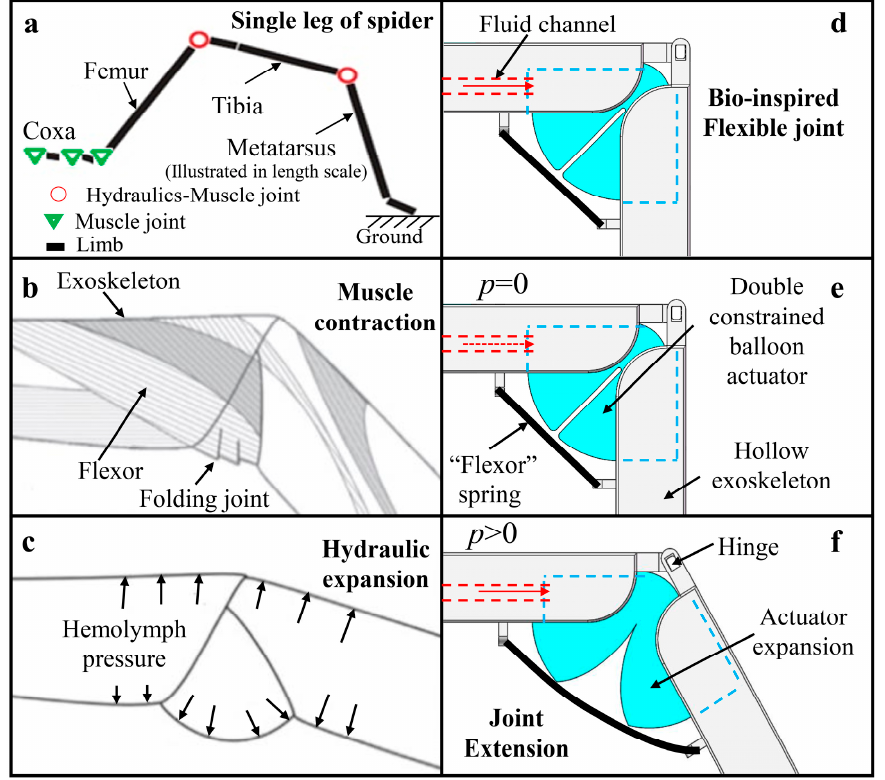
Figure 1. Principle of hydraulic muscle co-drive joint. ( a ) Single leg of spider (illustrated in length scale); ( b ) Flexor-induced joint flexion; ( c ) Hydraulics-induced joint extension; ( d ) Bio-inspired flexible joint; ( e ) Flexion of proposed joint; ( f ) Extension of proposed joint.